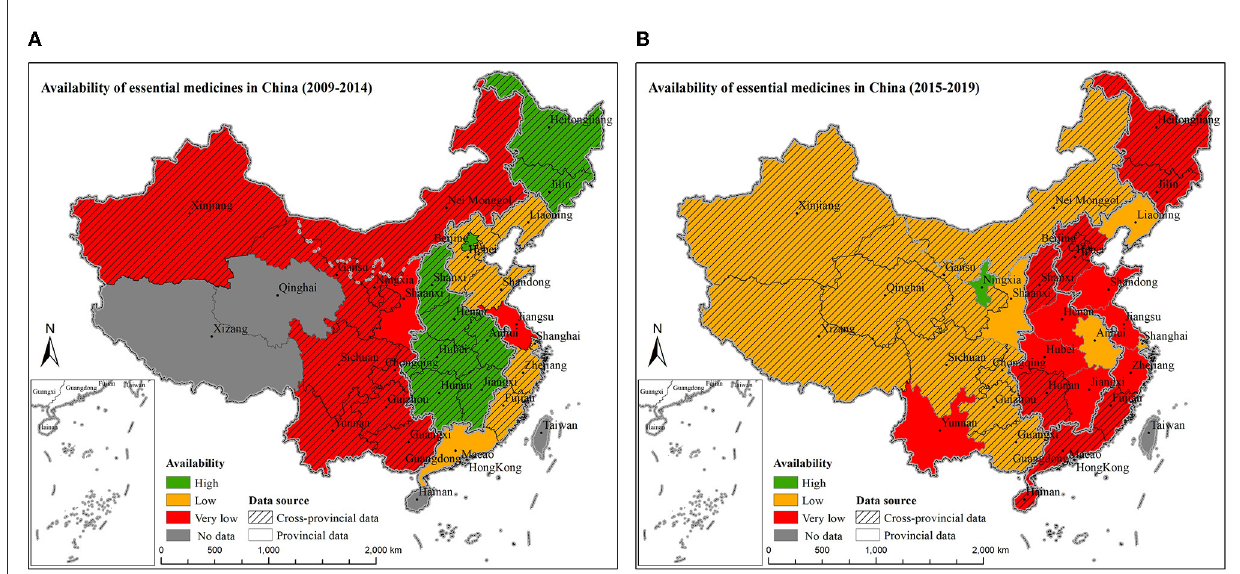
FIGURE3 The availability of essential medicines by provinces from 2009 to 2014 (A) and from 2015 to 2019 (B). Availability of essential medicine considered as: high > 80%, fairly high 50–80%, low 30–49%, very low < 30%. Methods for data manipulation for provinces with missing data in the map: if the province has been surveyed but the provincial data were not available, regional data (pooled estimate using meta-analysis) were used to fill in the data; if no survey has been conducted in the province at all, then it was labeled as no data. (From 2009 to 2014, provincial data were available for Beijing, Jiangsu, Guangdong, and Shaanxi; whereas, from 2015 to 2019, provincial data were available for Jiangsu, Liaoning, Shanghai, Zhejiang, Shandong, Anhui, Jiangxi, Henan, Hubei, Shaanxi, Yunnan, and